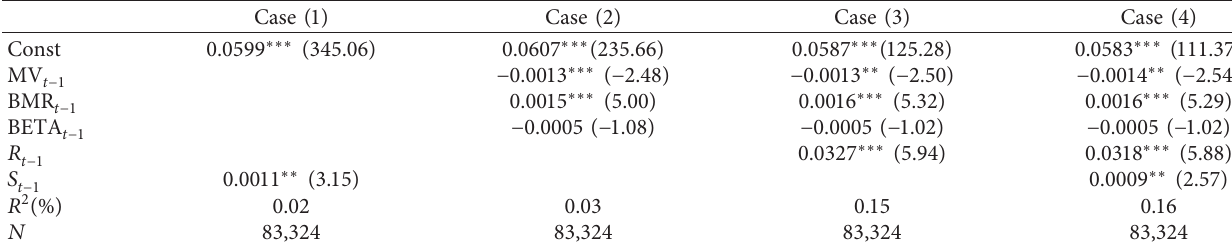
Table 5: Regression results of stock return and investor